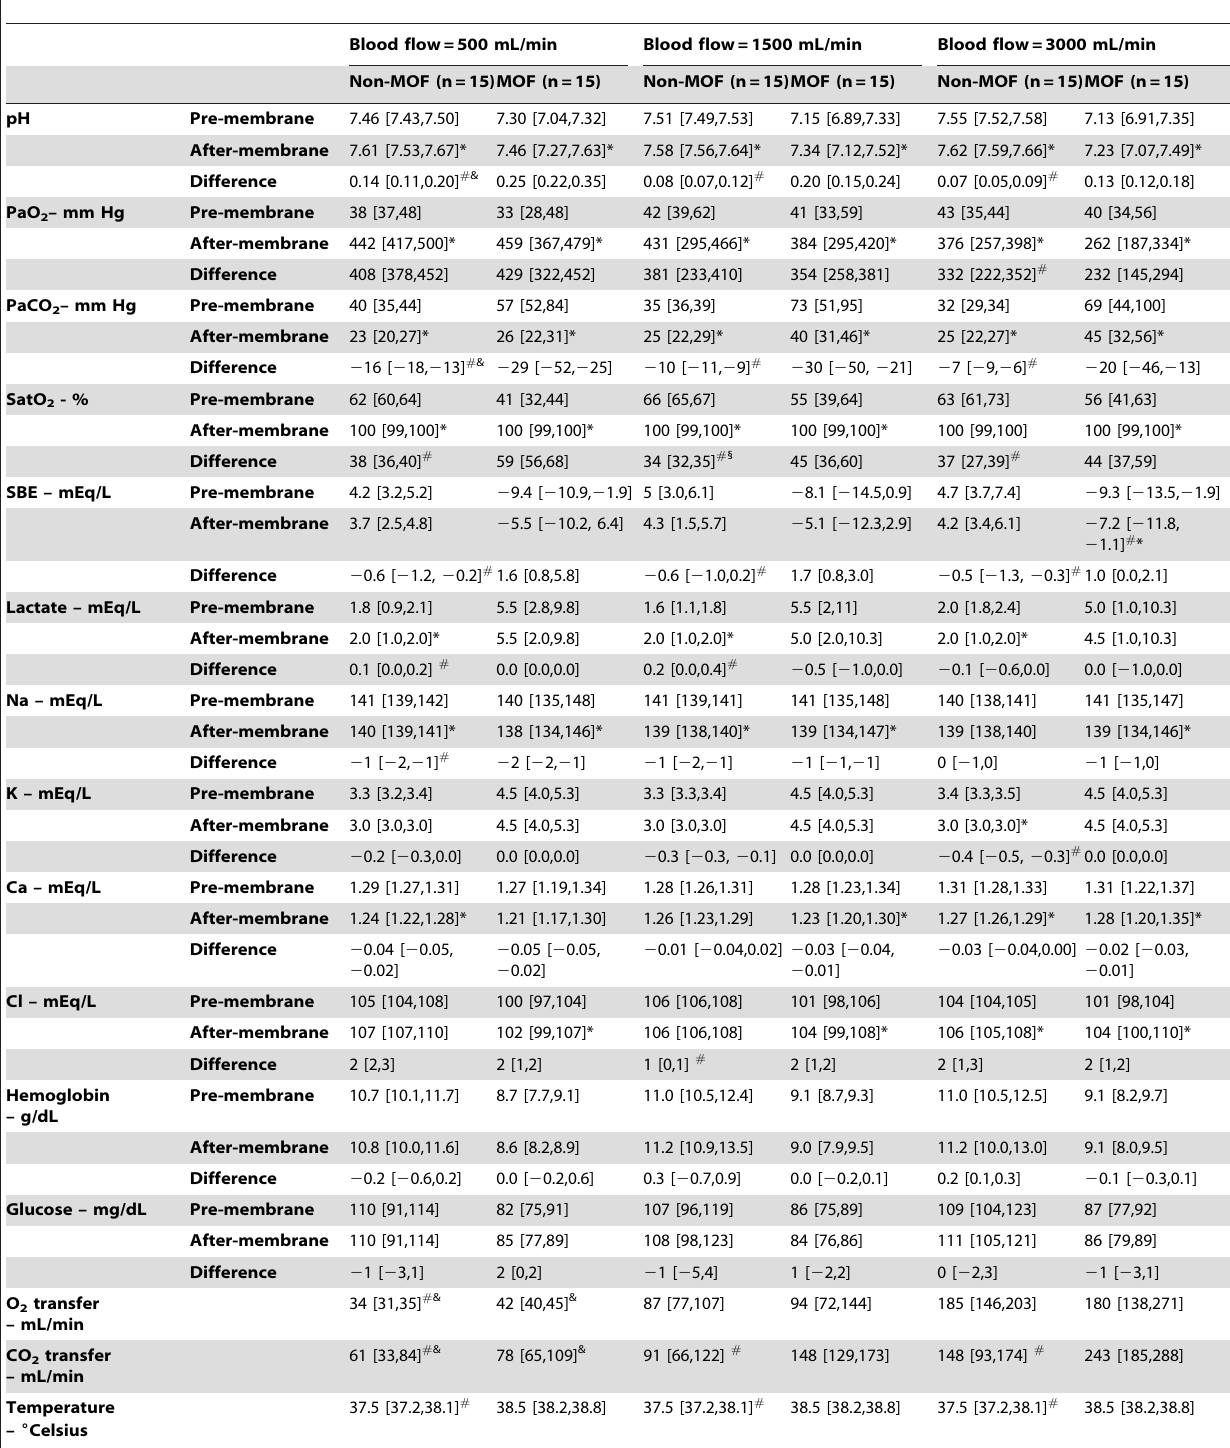
Table 4. Comparison of laboratory variables between the blood samples acquired pre and after the oxygenation membrane, during different blood flows with and without